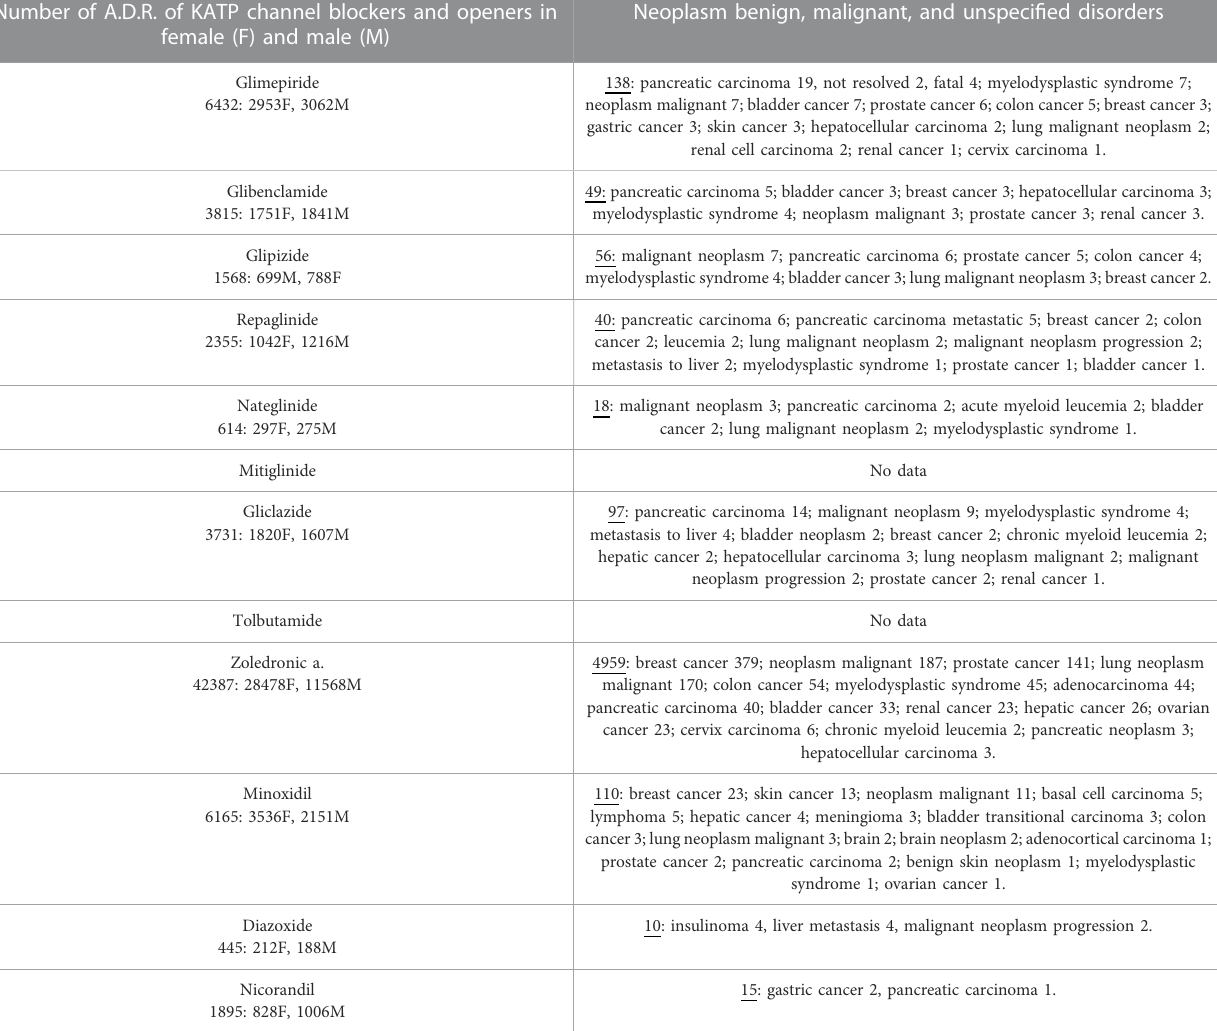
TABLE 4 Adverse drug reactions (A.D.R.) of KATP blockers and openers reported under the System Organ Class (S.O.C.): Neoplasm benign, malignant, and unspeci fi eddisordersandpreferred termsP.T.The not-speci fi edcategorywasnotincluded inthepresenttable.DatawerepooledfromEudraVigilance database. Number of A.D.R. of KATP channel blockers and openers in Neoplasm benign, malignant, and unspeci fi ed female (F) and male (M)